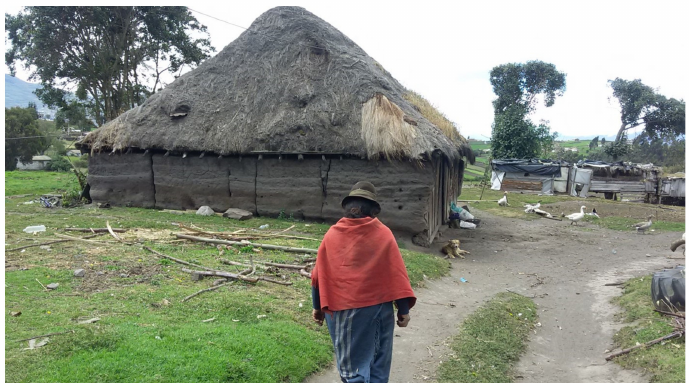
Figure 6. Shacks with poor hygienic